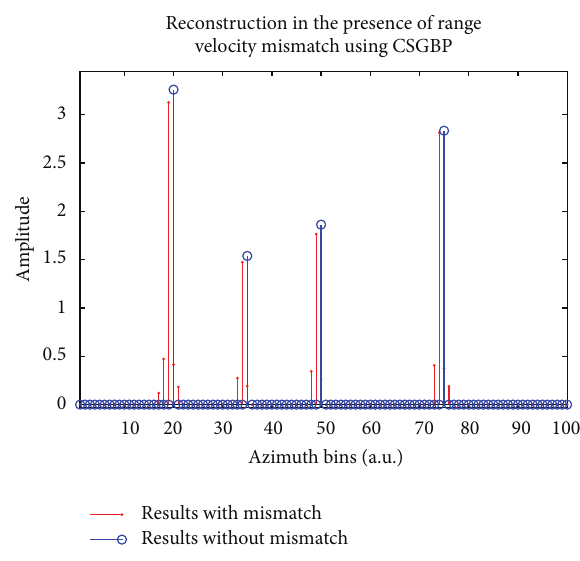
Figure 3: MSE for range velocity mismatch using CSLP and CSGBP.